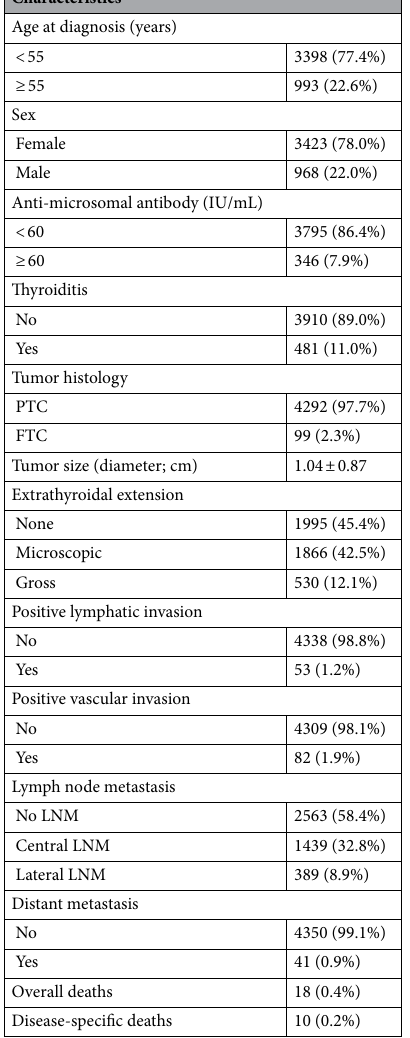
Table 1. Baseline characteristics of enrolled patients. Continuous data are presented as mean ± SD; categorical data are presented as absolute numbers (percentage values). PTC papillary thyroid carcinoma, FTC follicular thyroid carcinoma, LNM lymphnode